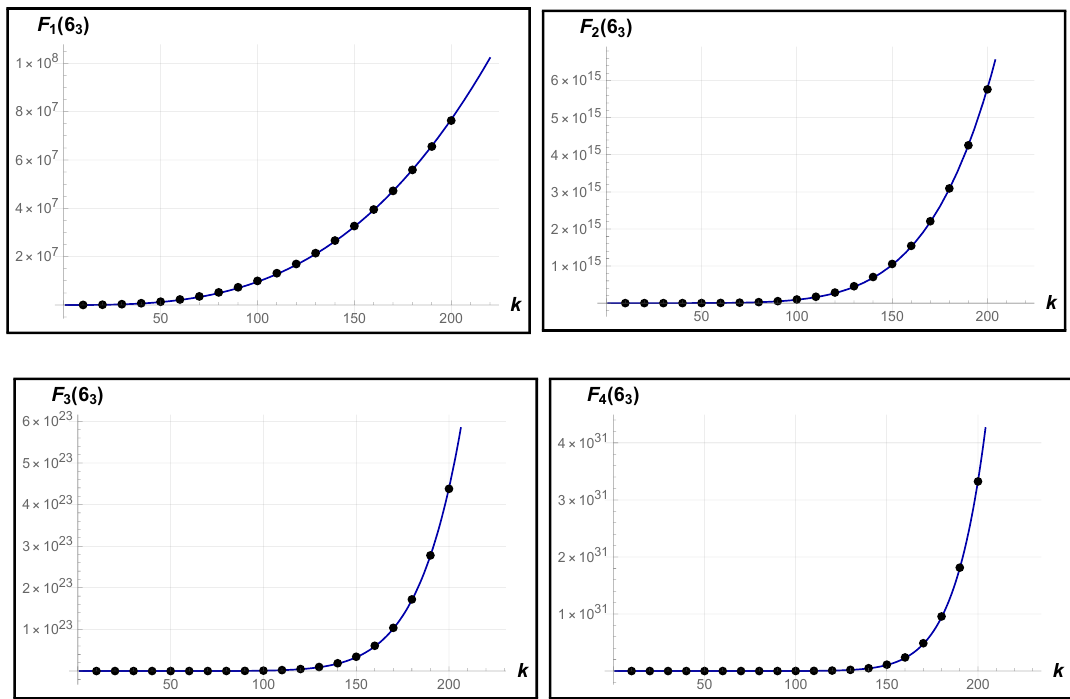
Figure 23. The variation of the function F m with k for 6 3 knot. The solid line denotes the function C m k 3 m with values of C m given in table 14. The • indicates the numerical values of F m obtained from explicit computations.